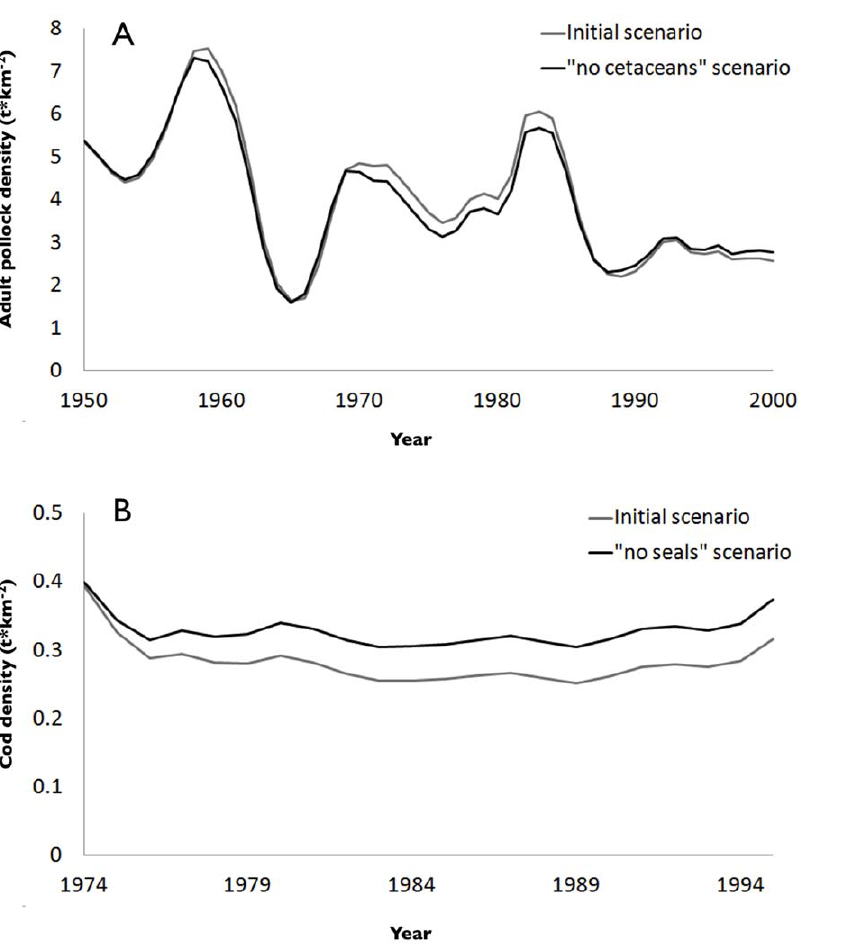
Figure 3. Change in commercially important fish biomass before (grey line) and after (black line) the simulated eradication of all marine mammals. Examples for pollock and cetaceans in the Eastern Bering Sea (A) and for cod and seals in the North Sea (B).